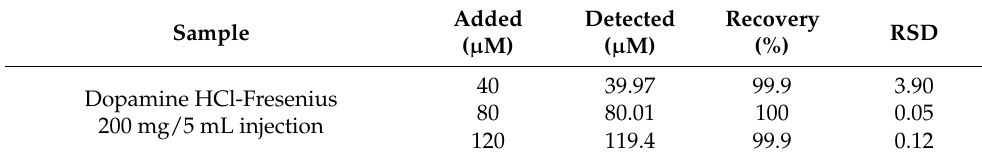
Fresenius 200 mg/5 mL